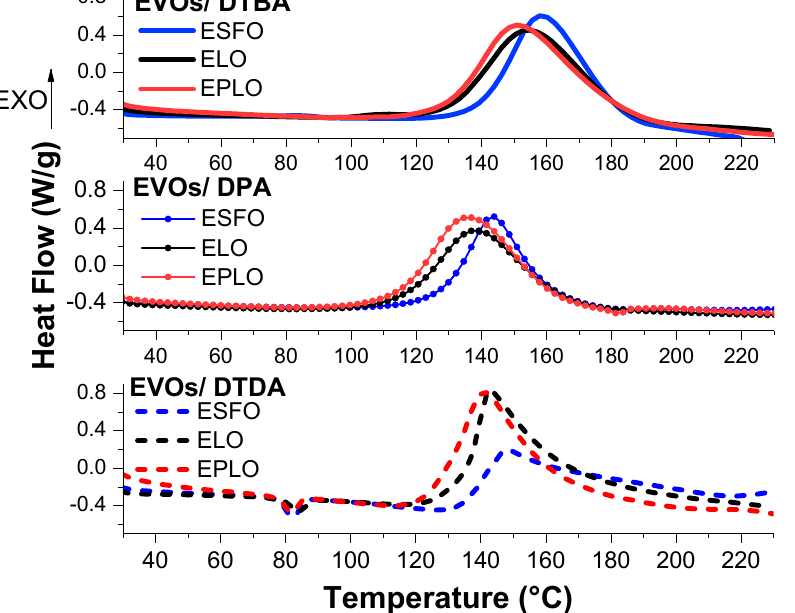
Figure 1. DSC thermograms during the process of curing epoxidized vegetable oils (EVOs) with DTBA and DPA aromatic hardeners or with the DTDA aliphatic crosslinker in R e/a = 1. Heating at 10 ◦ C/min from 25 to 250 ◦ C. Each EVO’s curve is represented in a specific colour: red for EPLO, black for ELO and blue for